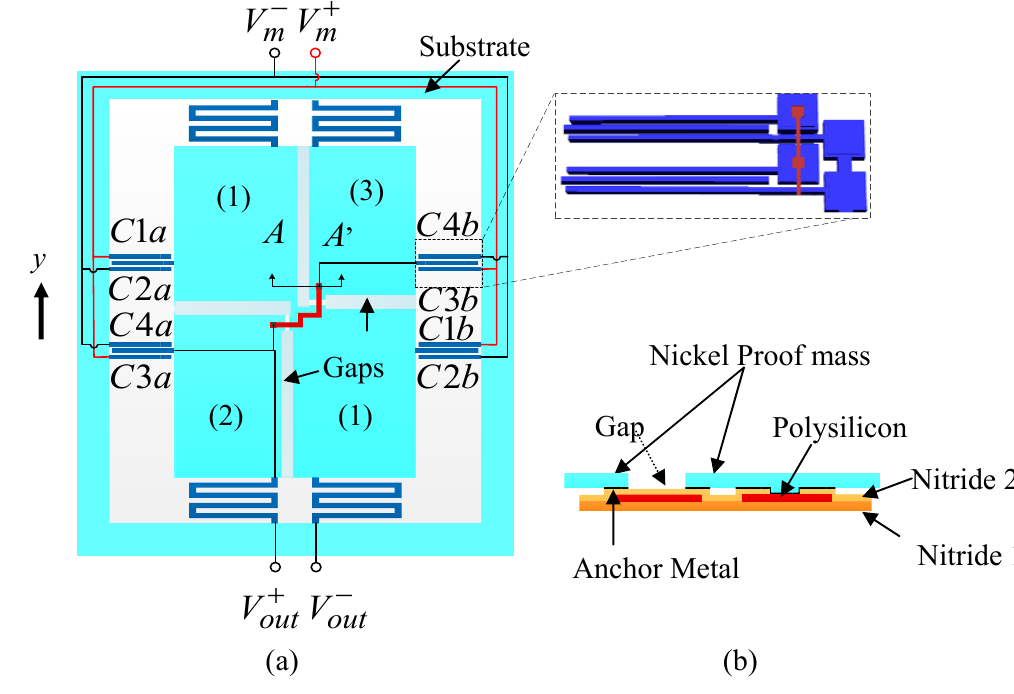
Figure 3. ( a ) Fully differential configuration of the accelerometer with inset showing the connection of sensing electrodes; and ( b ), cross-sectional view along AA’ (in (a)) showing mechanical connections of the proof mass piece (1) and (3). The polysilicon underneath the gap is used for mechanical